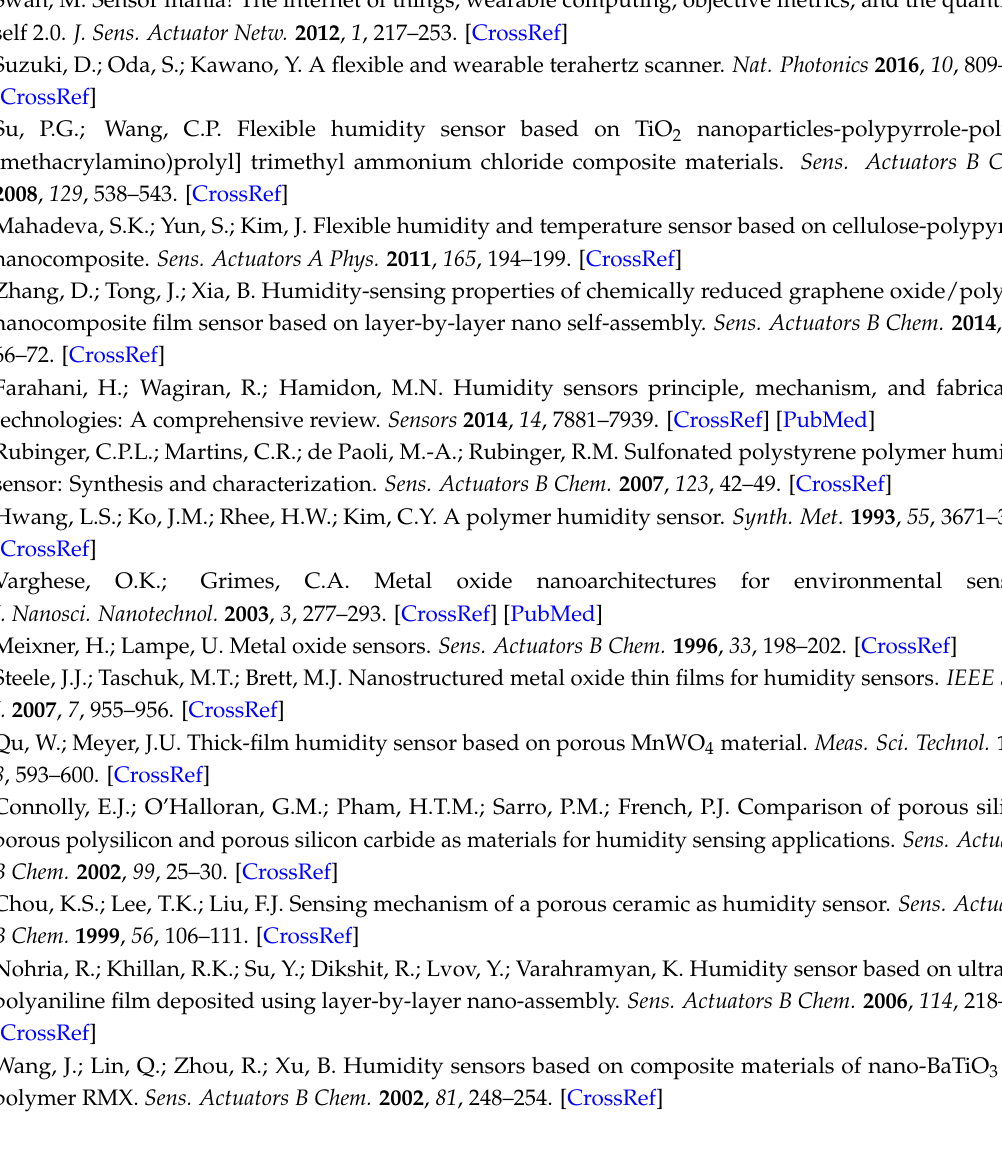
Table S1. Triboelectric table predicting which will become positive vs. negative and how strong the effect will be. Figure S1. Schematic drawing of various GO coating process on SF. For comparison, DI-soaked SF (SW) was also prepared. Figure S2. (a) and (b) SEM images of GO-coated SF (SL) (scale bar: 1 µ m). Figure S3. EDS images of GO-coated SF (SL) along with the quantitative data. (a) SEM image of the SL, (b) the elemental maps using both C K and O K, (c) C K, and (d) O K, (scale bar : 20um). Figure S4. Resistance of GO-coated SF at various conditions as a function of distance; SFs were rubbed with each material (glass, aluminum, and latex) before soaking in GO